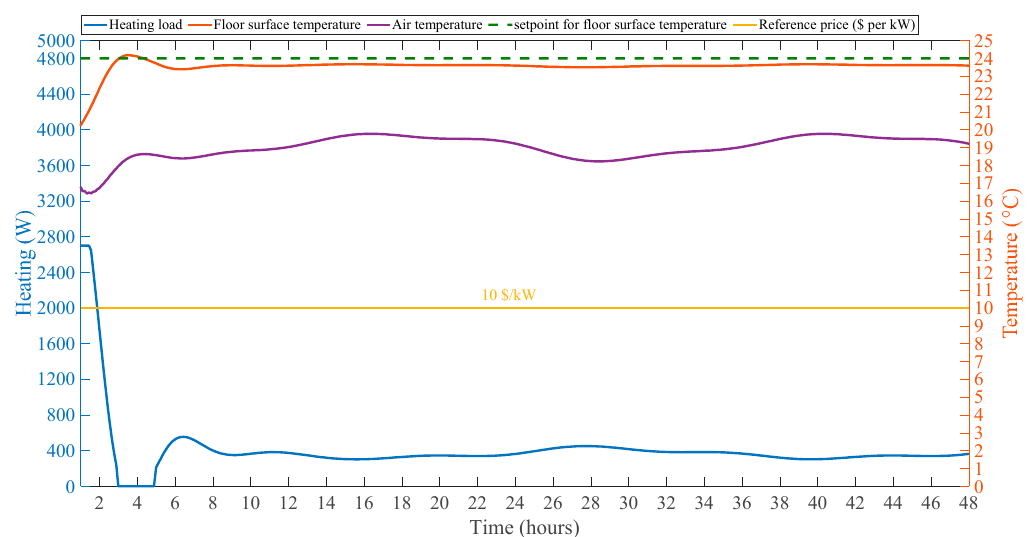
Figure 7. Reference conditions and power price for floor surface temperature setpoint of 24 °C.